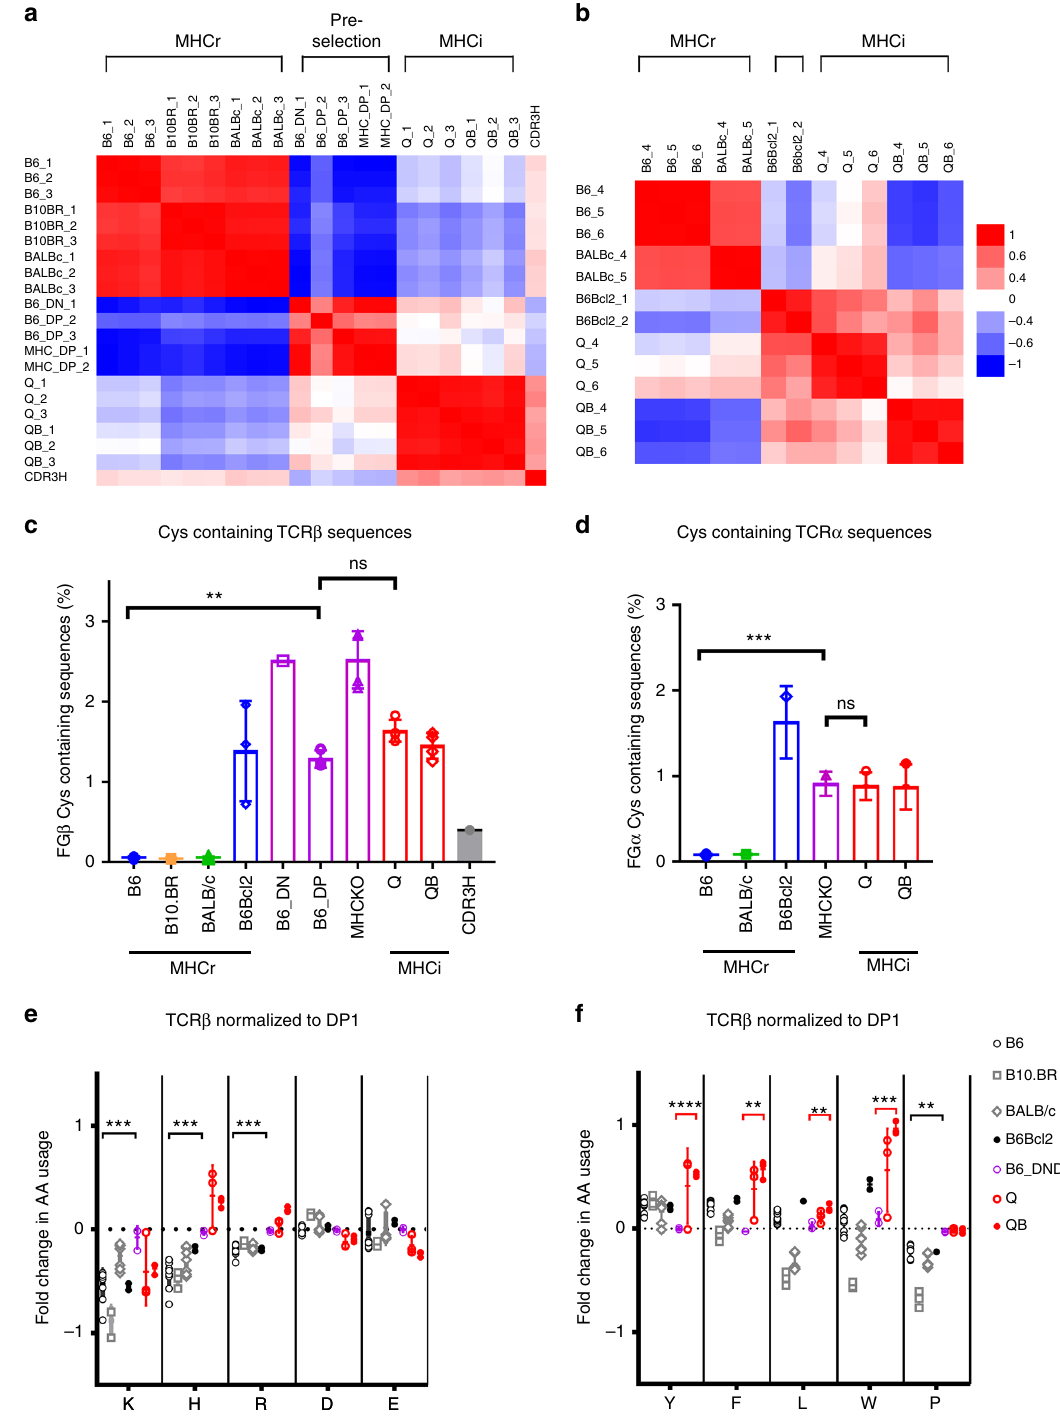
Fig. 5 Comparison of Amino acid usage in TCR CDR3 FG-loop from MHCr, MHCi and pre-selection repertoires. a , b Pearson correlations calculated using normalized amino acid usage among MHCi, MHCr and pre-selection TCR repertoires. The FG β - ( a ) and FG α -loop ( b ) amino acid usage frequencies of individual repertoires are normalized against those of B6 DP_1 and MHCKO DP, respectively. The pair-wise Pearson correlation coef fi cients were displayed as heatmaps to indicate the distinct amino acid usages of MHCi, MHCr and pre-selection TCR repertoires. c , d The frequency of Cys-containing TCR β ( c ) and TCR α ( d ) sequences in MHCr, MHCi and the pre-selection repertoires. e , f Fold changes of charged and hydrophobic amino acid usages observed in various repertoires. Amino acid frequencies are normalized to those in B6_DP1